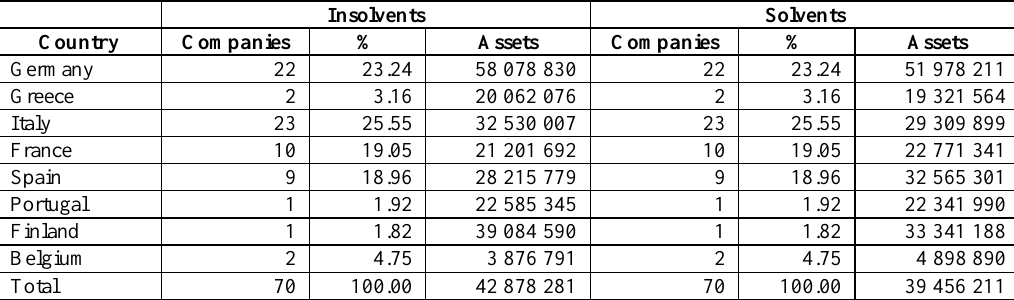
Table 6. Sample structure of the industrial companies used as contrast